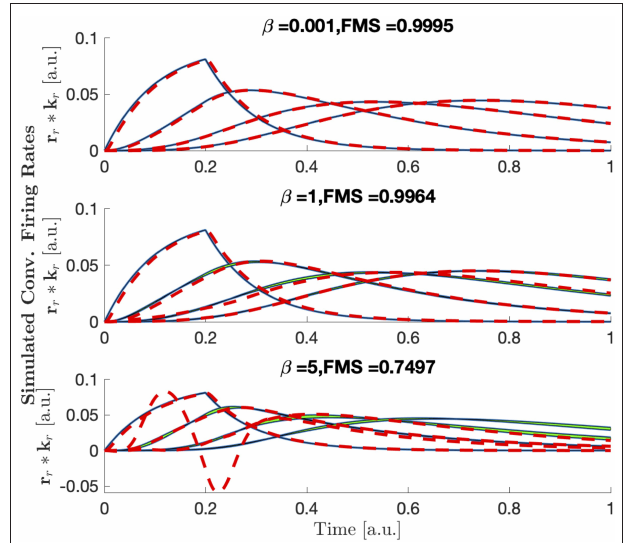
FIGURE 7 | The mean ± 3 standard deviations of each population’s convolved firing rate across trials (blue) with area between the two curves shaded in green and CP reconstruction plotted as dashed red lines for increasing amounts of non-linearity. Larger green regions represent larger shape changes in the normalized firing